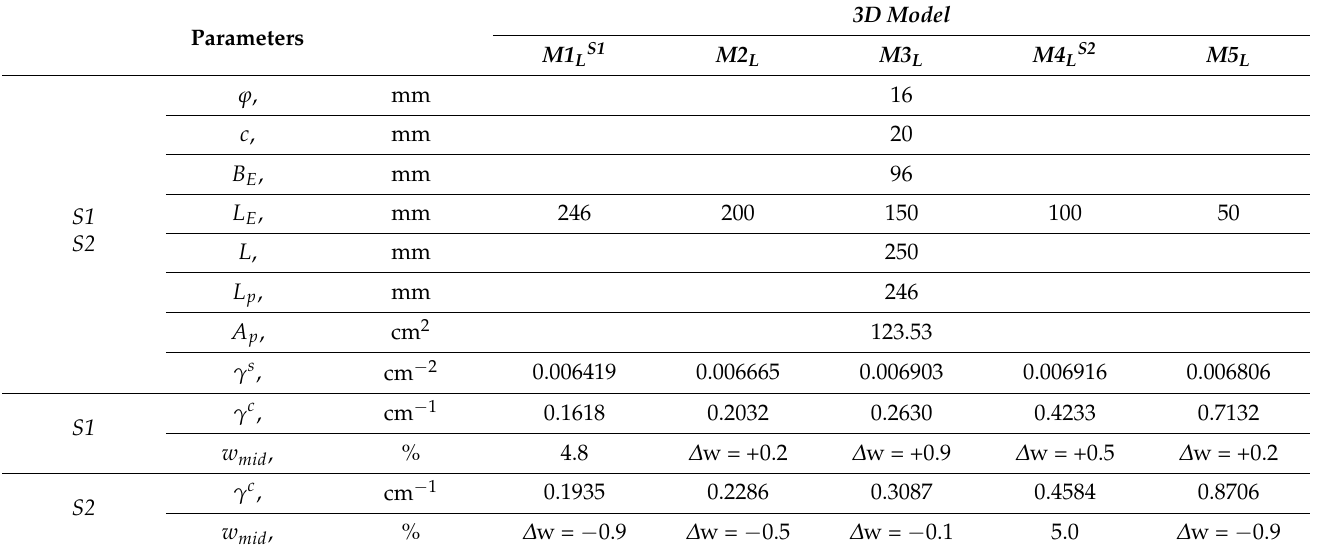
Table 2. Geometric parameters of the 3D model at a variable length L E of the counter electrode and average moisture content in concrete considered in the computational analysis of impedance spectra of steel in concrete of series S1 and S2